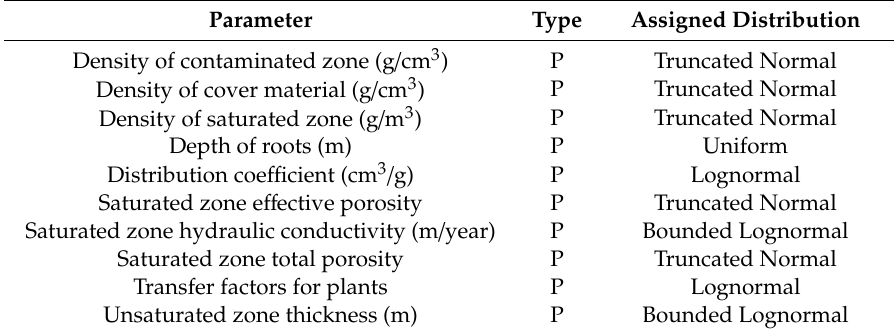
Table 1. Priority 1 parameter list and assignment of probability density